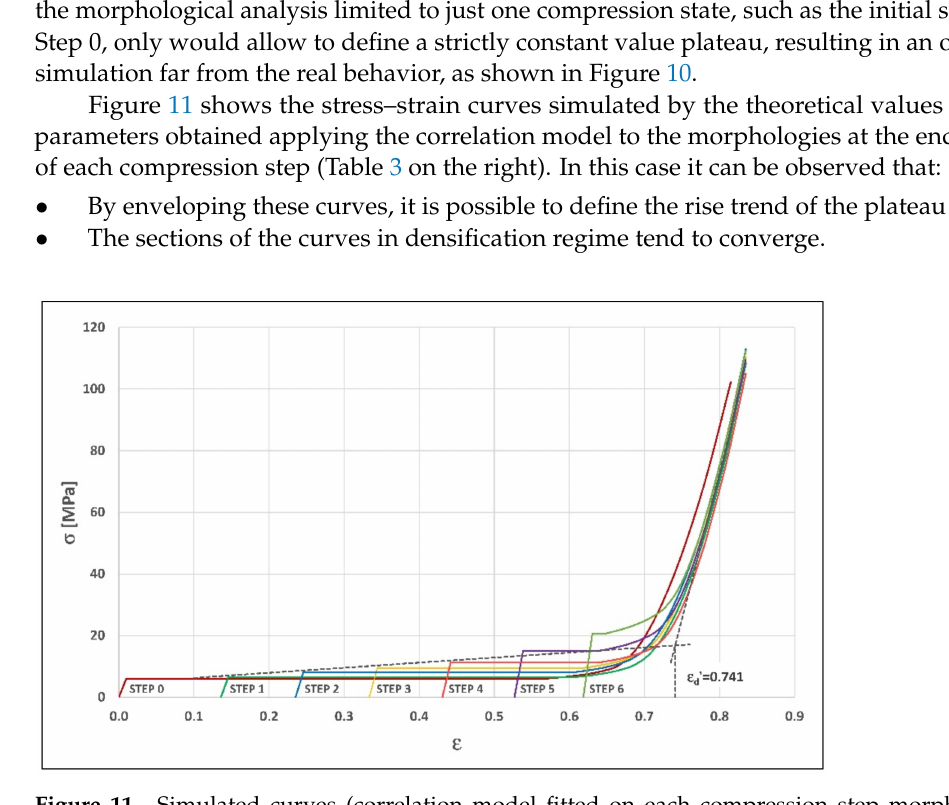
Figure 11. Simulated curves (correlation model fitted on each compression step morphology, 0.4% TiH 2